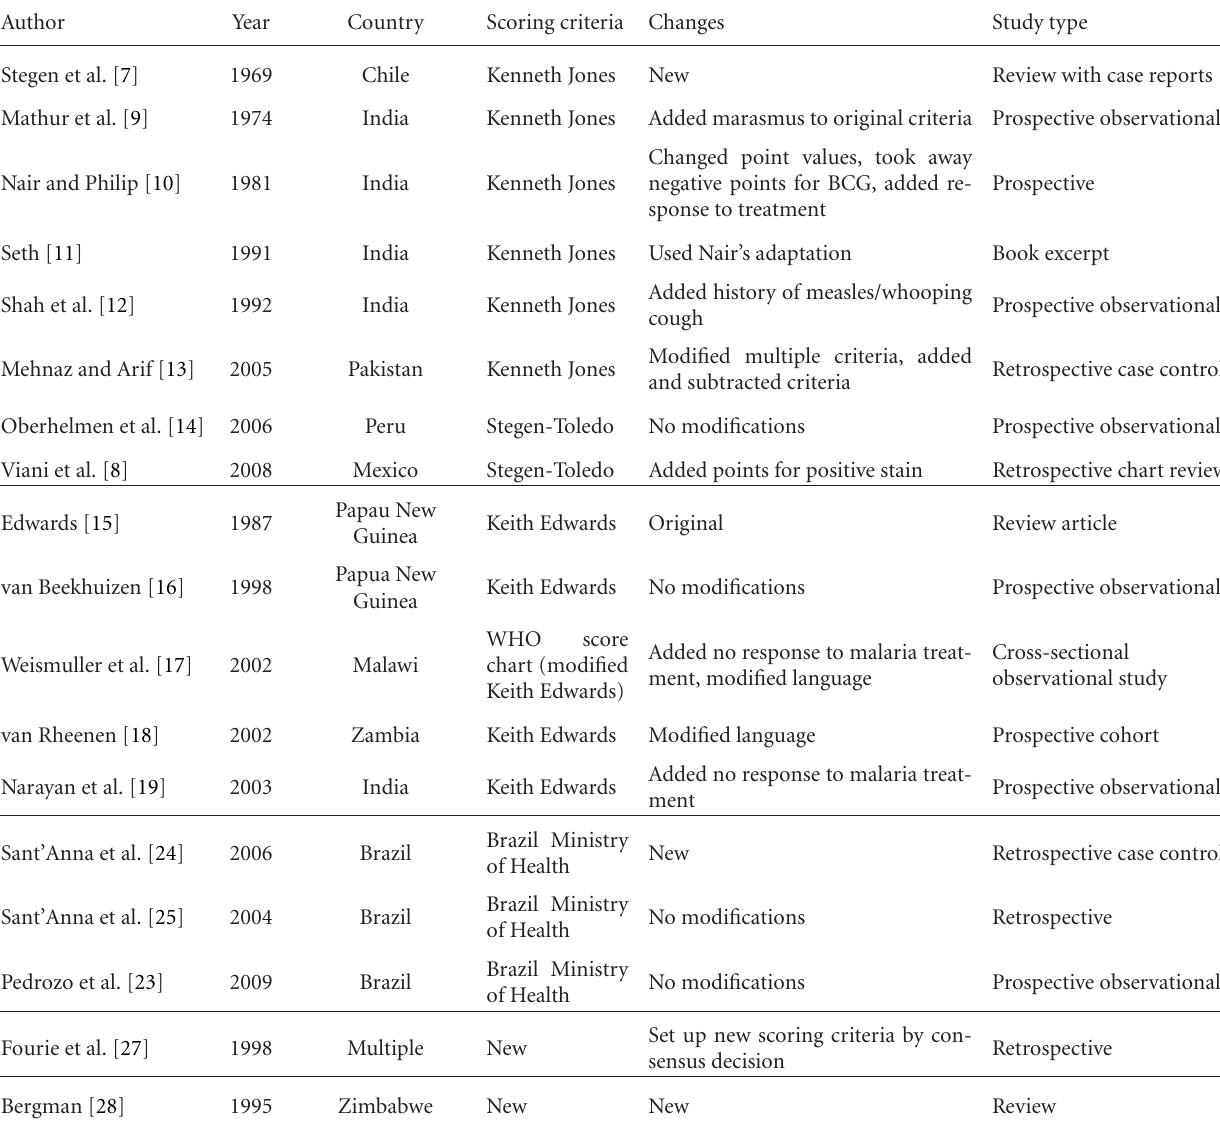
Table 1: Point-based scoring systems and studies evaluating these